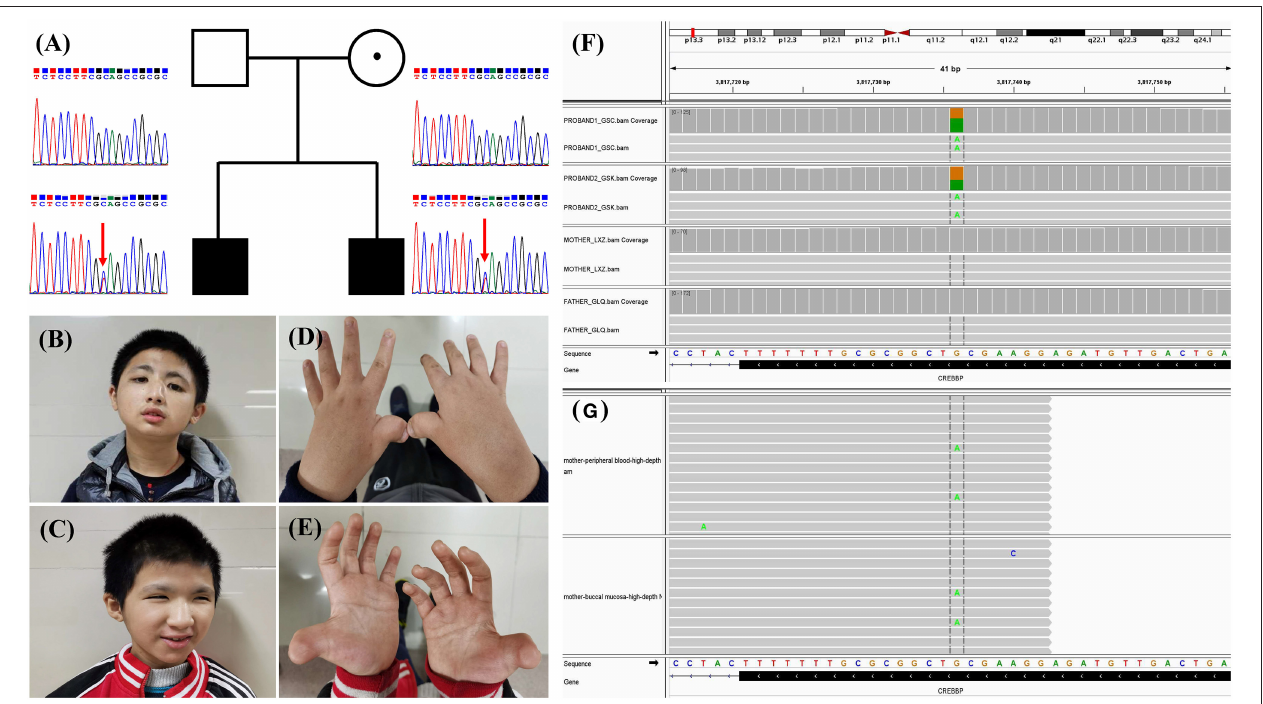
FIGURE 1 | (A) Family pedigree and Sanger sequencing results of the CREBBP variant. The arrows indicate the variant c.3235C > T in the siblings. (B,C) Photos of the two siblings. (D,E) Hand morphology of the two siblings. Typical features include broad and angulated thumbs. (F) Sequence read alignment of the c.3235C > T (16:3817736:G > A) site from the BAM files of trio whole-exome sequencing using Integrative Genomics Viewer (v2.8.1) indicated a variant allele fraction for c.3235C > T of ∼ 50% in the siblings but not in the parents. (G) Sequence read alignment of the c.3235C > T (16:3817736:G > A) site from the BAM files of